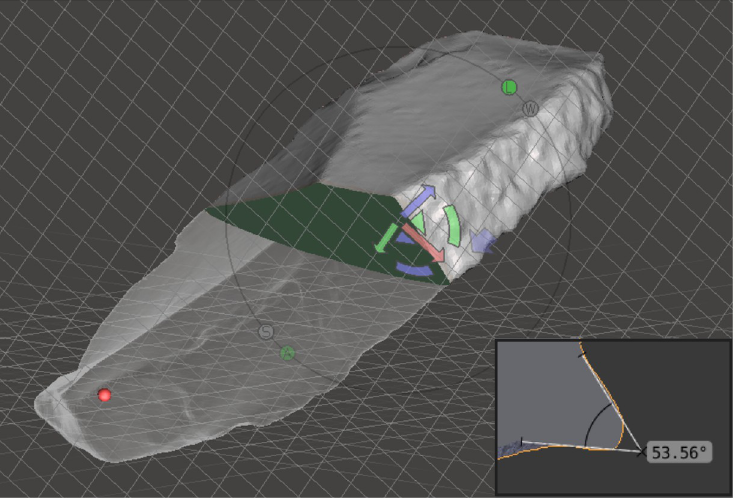
Fig 5. Representation of cross-sectioning a virtual model of lithic tool and acquisition of angles’ data in cross- section.